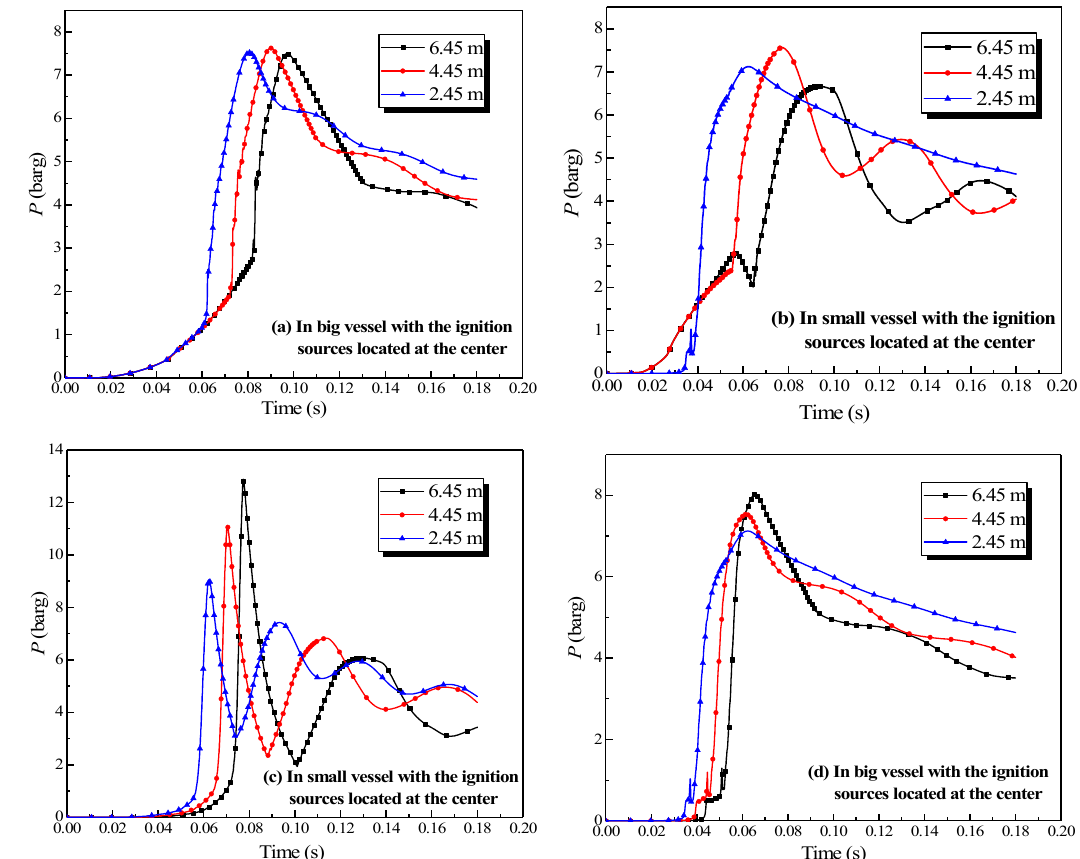
Figure 13. Natural gas explosion pressure-time curves in the vessels with changing the length of the pipe.